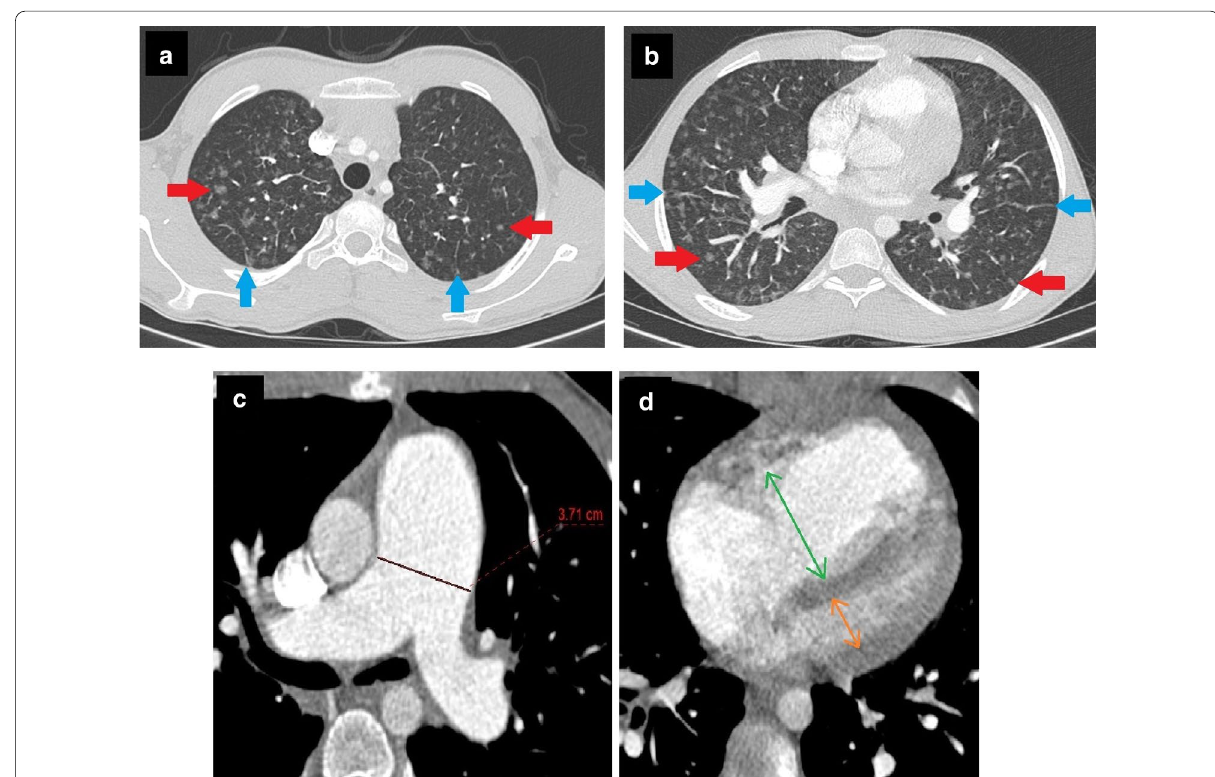
Fig. 2 Discrepancy . A 13-year-old male patient with a history of pigeon-feeding presented at the Pediatric Department with the complaint of dyspnea. Clinicians suspected “hypersensitivity pneumonitis” as the first differential. The patient was hospitalized for further management. Serological tests proved the presence of antibodies against specific avian proteins. Thorax CT showed multiple ground-glass nodules (red arrows, a , b ). A radiologist interpreted these nodules in favor of "hypersensitivity pneumonia" considering the clinician’s opinion, patient history and serological test results. According to another radiologist, pulmonary veno-occlusive disease was more likely, because of accompanying interlobular septal thickening (blue arrows, a , b ), increased pulmonary artery diameter ( c ) and right ventricular dilatation ( d ). Although the radiologists were aware of each other’s opinions, both had plausible and supportive arguments for their provisional diagnosis. After a brief discussion, both possibilities were mentioned in the report, but both radiologists thought their own diagnosis was correct. After evaluating both possibilities in the multidisciplinary meeting, it was decided how to proceed with patient